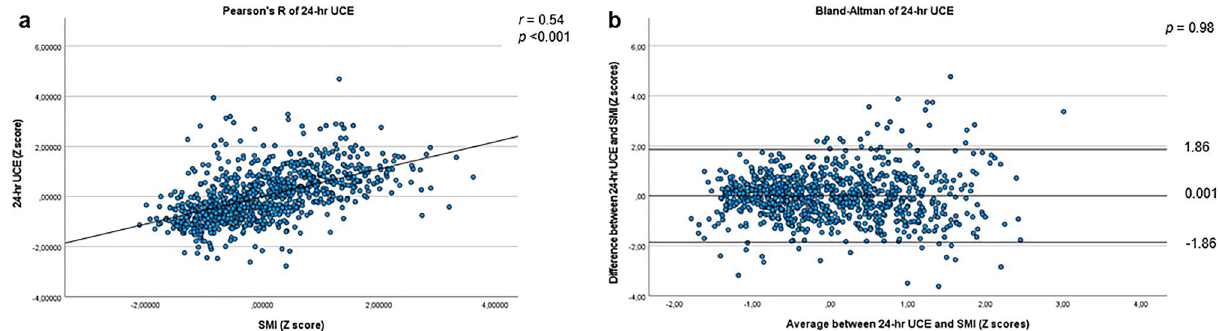
Figure 2. Pearson’s correlation and Bland–Altman plots of 24-h UCE and SMI. ( A ) Pearson’s correlation of 24 h urinary creatinine excretion (24-h UCE) and skeletal muscle index (SMI); ( B ) Bland–Altman plot of 24 h UCE and SMI. The middle horizontal line in the Bland–Altman plot shows the mean of the differences (= bias) between the two methods, and the outer two horizontal lines show the upper and lower 95% limits of agreement (= bias ± 1.96 × SD). r : Pearson’s